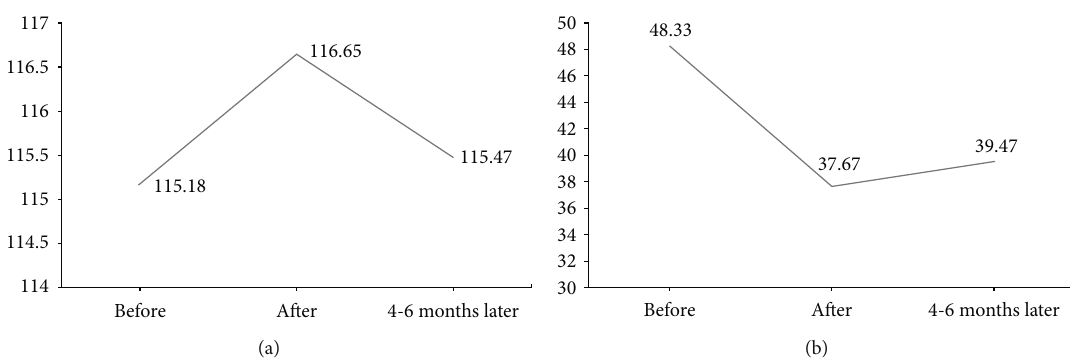
Figure 1: (a) Functional independence scale (FIM) data at follow-up measurements in study participants. (b) MFIS scale data on follow-up measurements in study participants.